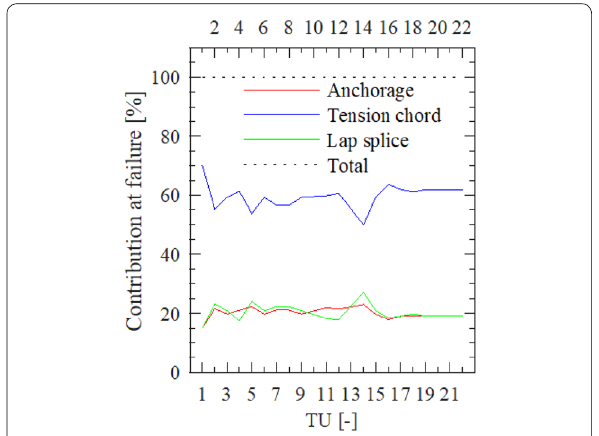
Fig. 12 Relative contribution of the three model elements to the total ultimate displacement (at tensile failure), as predicted by the model for all the test